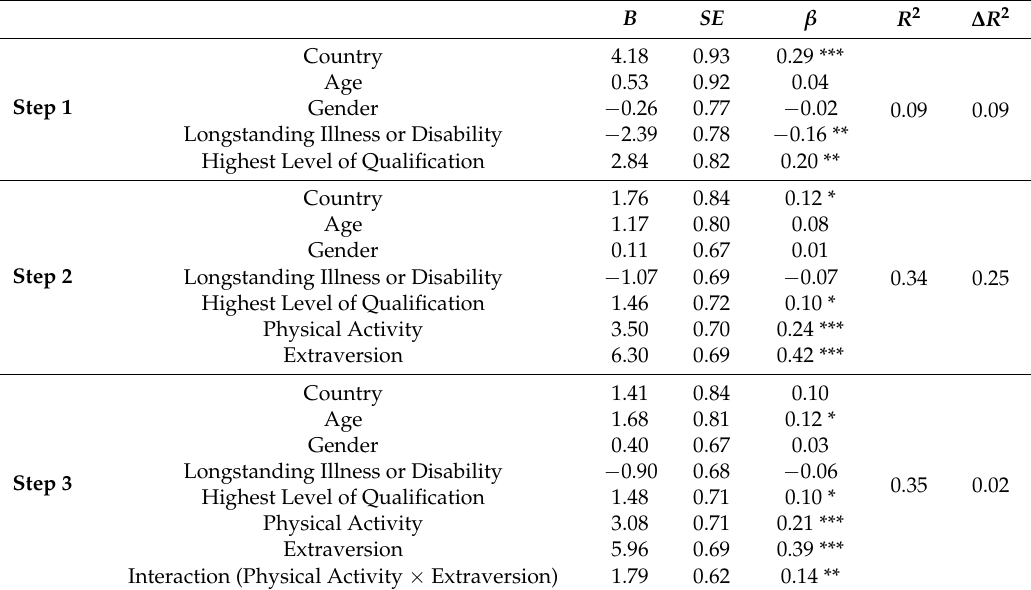
Table 4. Interaction analysis for physical activity and extraversion.